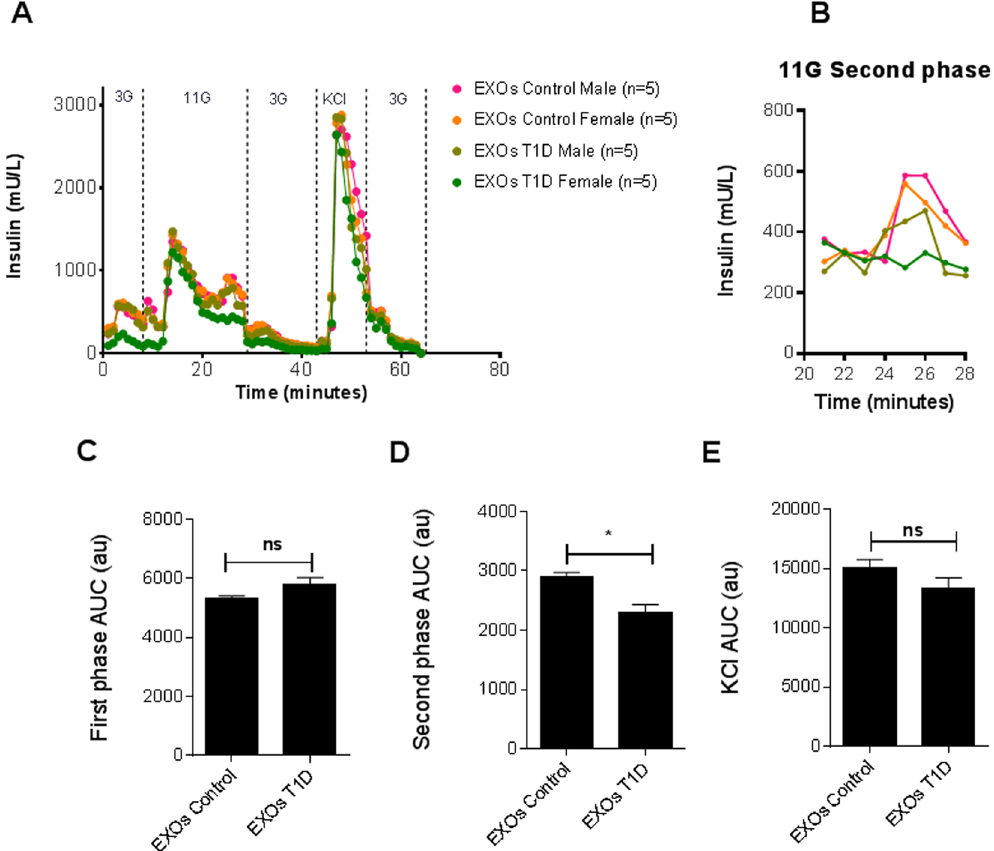
Figure 5. Effect of plasma-derived exosomes from T1D and controls on insulin secretion of perifused islets. Groups of 350 IEQ islets each, were stimulated every minute as shown in ( A ) for low (3 mM) → high (11 mM) → low (3 mM) glucose challenge followed by a KCl step. Pancreatic islet perifusion, normalized iInsulin secretion data to islet volume (IEQ). Data are expressed as ng insulin/islet equivalents (IEQs) per minute ( A , B ) or area under the curve (AUC) for each secretagogue ( C – E ). Statistical analysis was performed by Student’s t